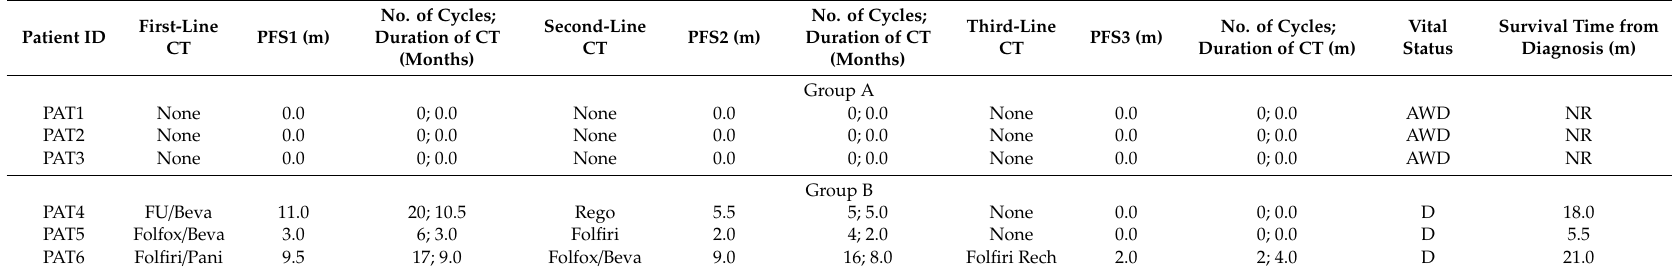
Table 2. Clinico-pathological characteristics of the enrolled patients